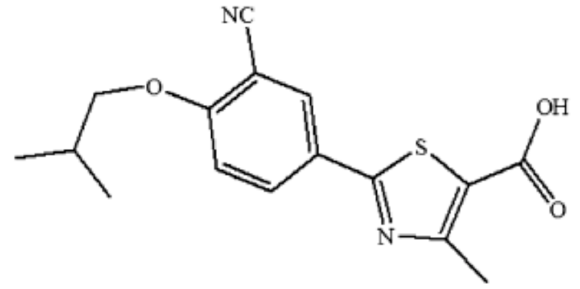
Figure 1. Chemical structure of febuxostat (FXT).